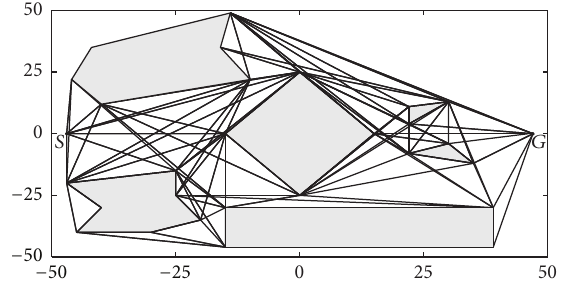
Figure 1: Complete visibility